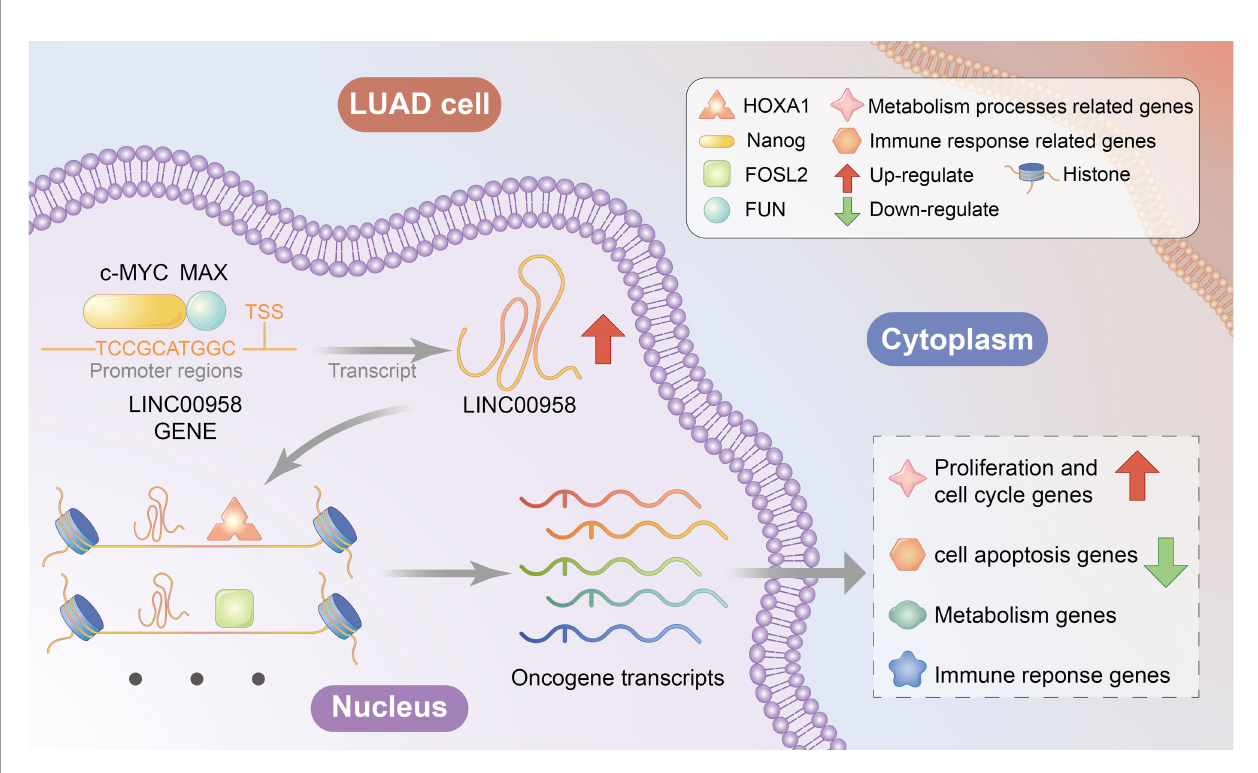
FIGURE 9 | Proposed mechanism of